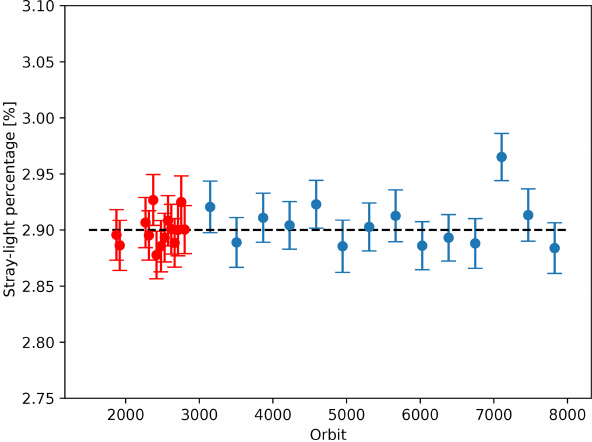
Figure 27. Results of all stray-light measurements with SLS-1 dur- ing the E1 phase (red, see Table 4) and nominal operations (blue)